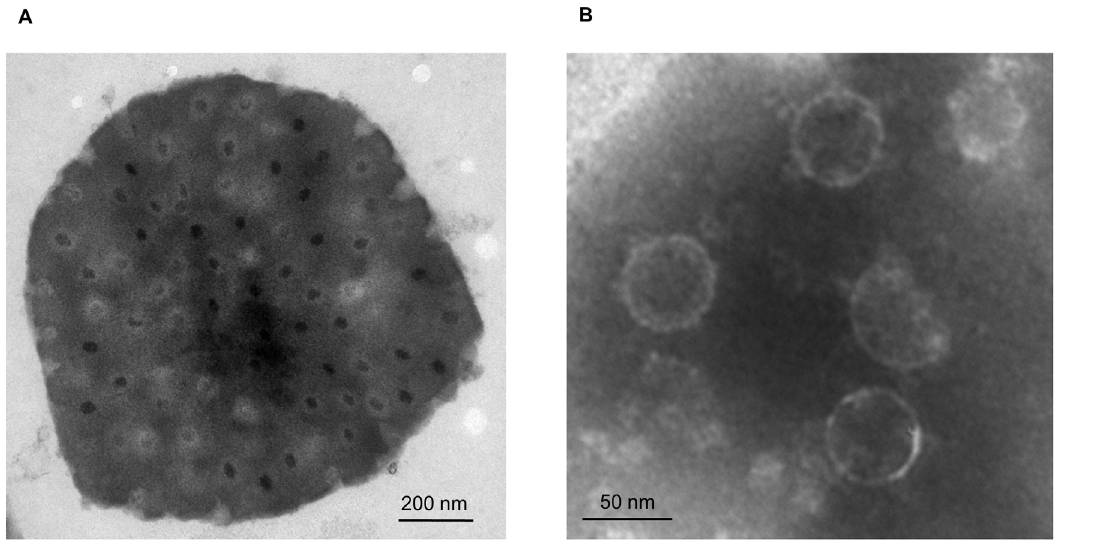
Figure 2. Electron micrographs of OBs of DpCPV-MC. (A) Transmission electron micrograph of ultrathin sections of OBs of DpCPV-MC. (B) Transmission electron micrograph of purified virions of DpCPV-MC.